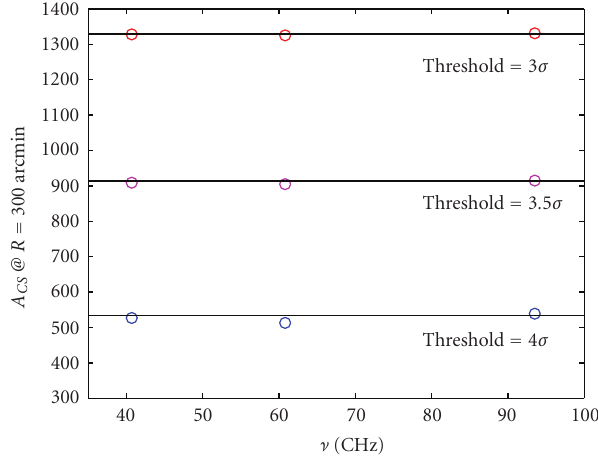
Figure 10: Frequency dependence of area of the SMHW coe ffi - cients. The plot shows the area of the wavelet coe ffi cients at R = 300 arcmin for di ff erent thresholds (from top to bottom: 3, 3.5, and 4 σ R ), as a function of the frequency. The circles represent the values obtained for cleaned CMB maps obtained from the WMAP data at three cosmological frequencies (Q-, V-, and W-bands). The solid lines represent the areas, at di ff erent thresholds, for the noise- weighted QVW